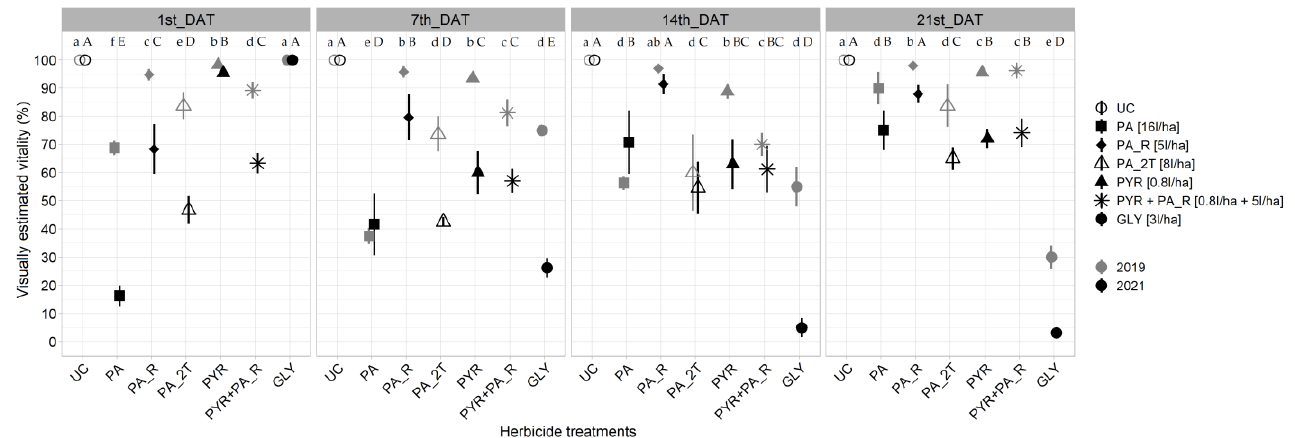
Figure 3. Visually estimated crop vitality after application of herbicides on the cover crop in both years. Small letters show significant differences among treatments within each day in 2019 and capital letters show significant differences among treatments within each day in 2021 at p < 0.05 using the Kruskal – Wallis test. Error bars indicate the standard deviation for each treatment within each assessment day.